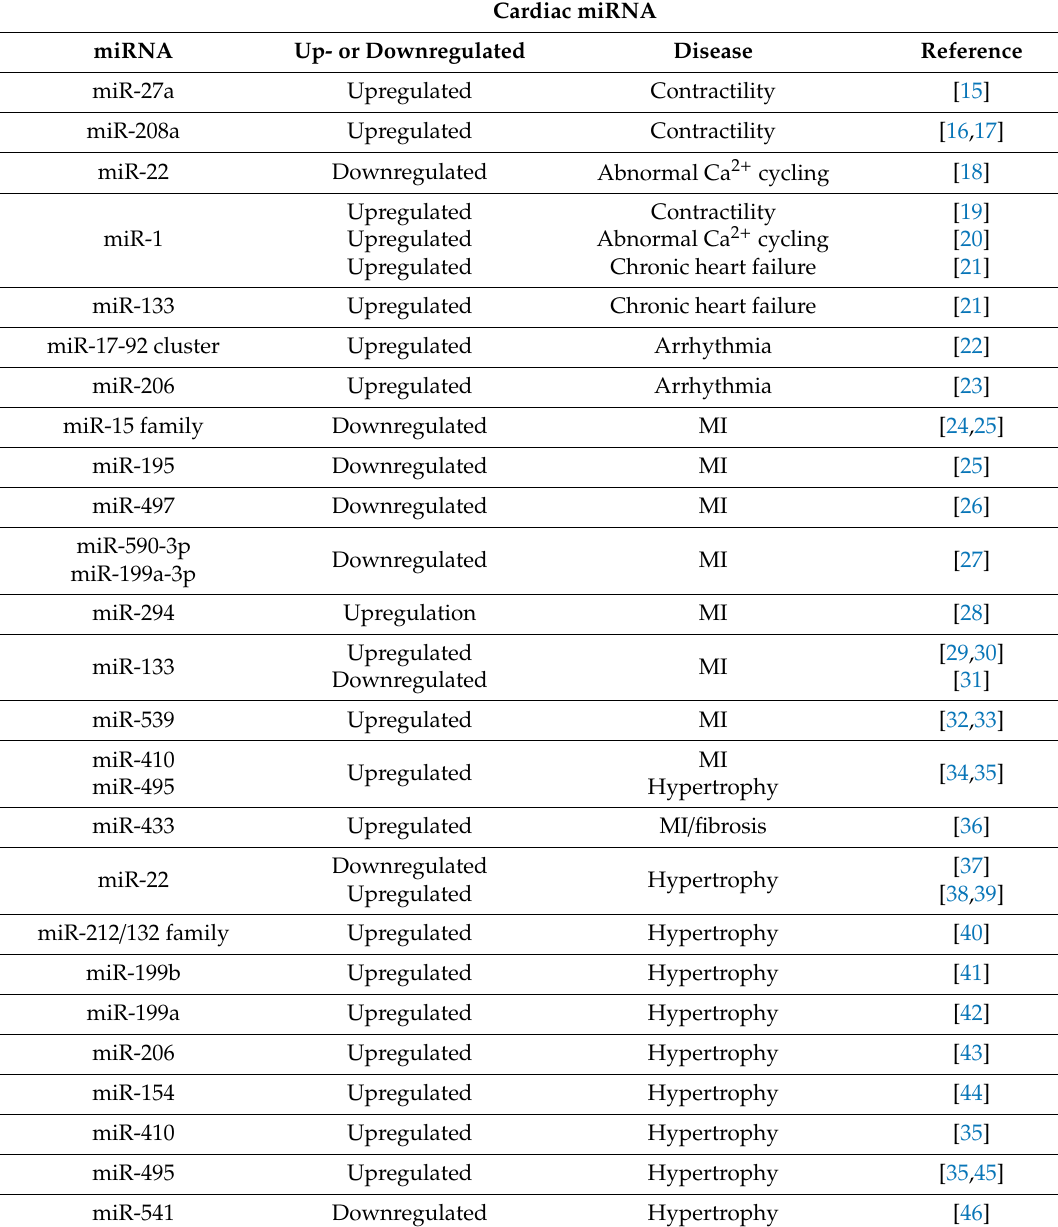
Table 1. MicroRNAs involved in cardiac health and disease. Overview of several microRNAs that play